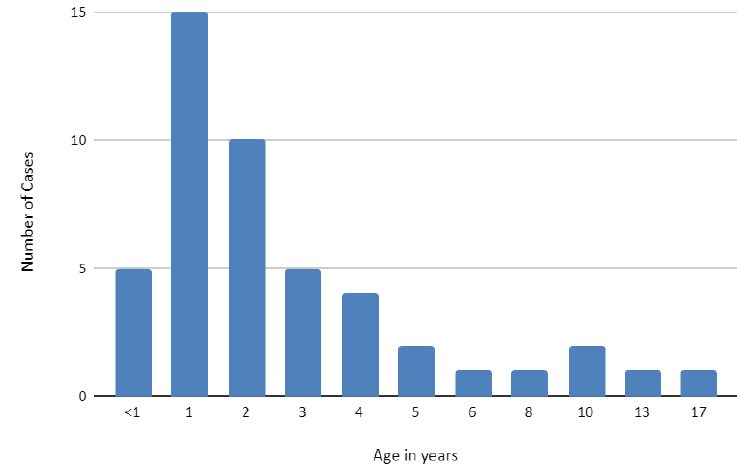
Figure 2. Age distribution of all pediatric burn patients.